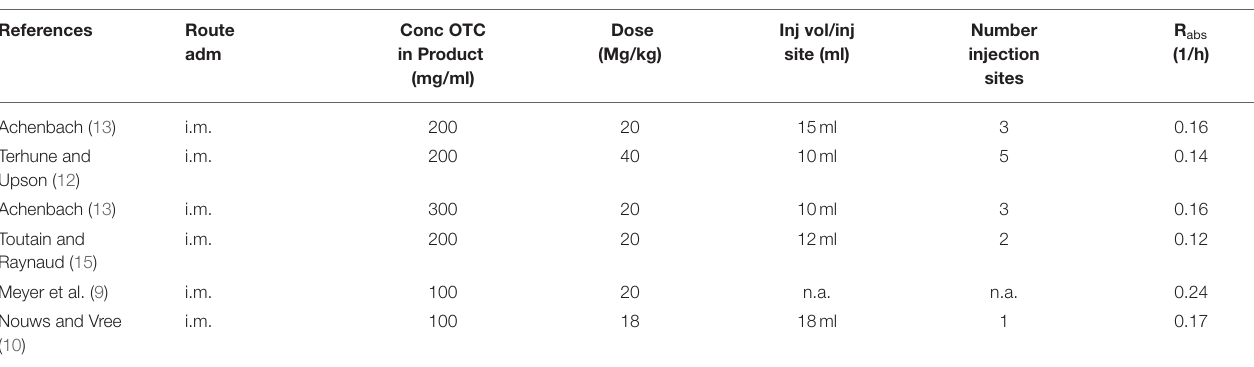
TABLE 5 | Overview of the results and data used for estimation of R abs